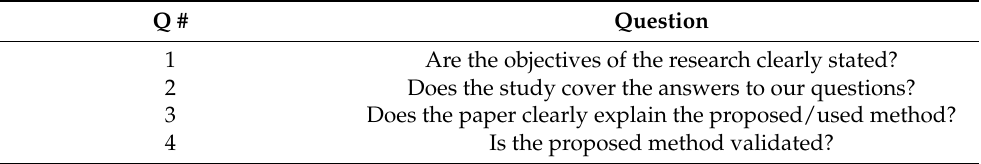
Table 3. List of